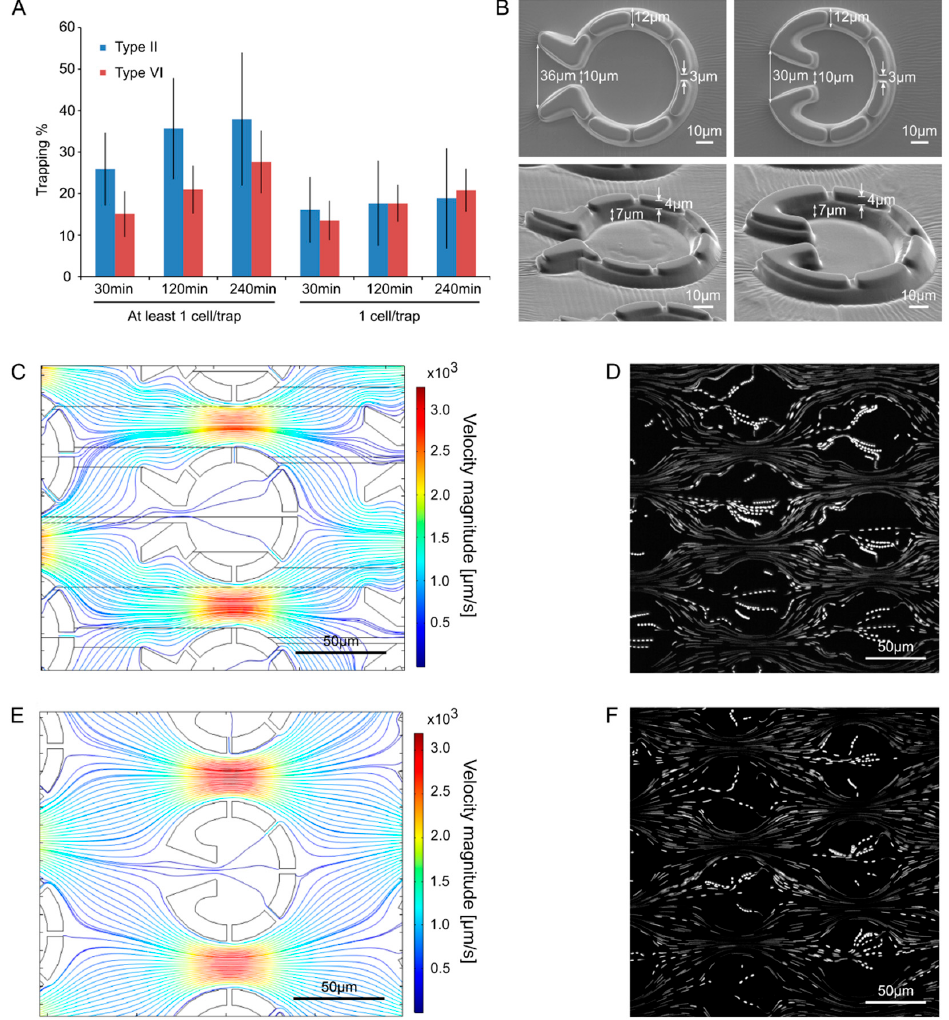
Figure 4. Comparison of “Pot” trap Types II and VI. ( A ) Comparison of the trapping efficiency. The cell loading lasted for 60 min and the trapping efficiency was assessed at 30, 120, and 240 min. The results represent the averages of three independent experiments with their standard error. No significant differences were detected between Types II and VI (Student t -test p < 0.05). ( B ) Scanning electron microscopy images of the traps from above and at tilted angles. ( C ) Computational modeling of the flow in trap Type II. The density of the streamlines and the color code represent the velocity magnitude. ( D ) Streamlines of the fluid flow visualized by fluorescent microbeads (1 µm) in trap Type II. ( E ) Computational modeling of the flow in trap Type VI. The density of the streamlines and the color code represent the velocity magnitude. ( F ) Streamlines of the fluid flow visualized by fluorescent microbeads (1 µm) in trap Type VI.